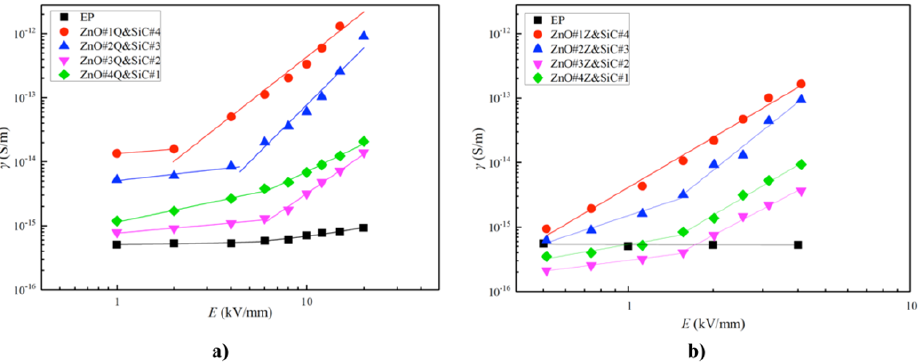
Figure 33. Conductivity–electric field characteristic curves of epoxy-based composite materials with different fractions of inorganic fillers: ( a ) nano-ZnO/SiC/EP nanocomposites and ( b ) micro-ZnO/SiC/EP micro/nanocomposites. Reprinted from